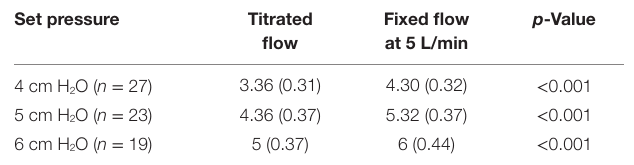
TaBle 1 | Delivered pressures at different set cPaP pressures.